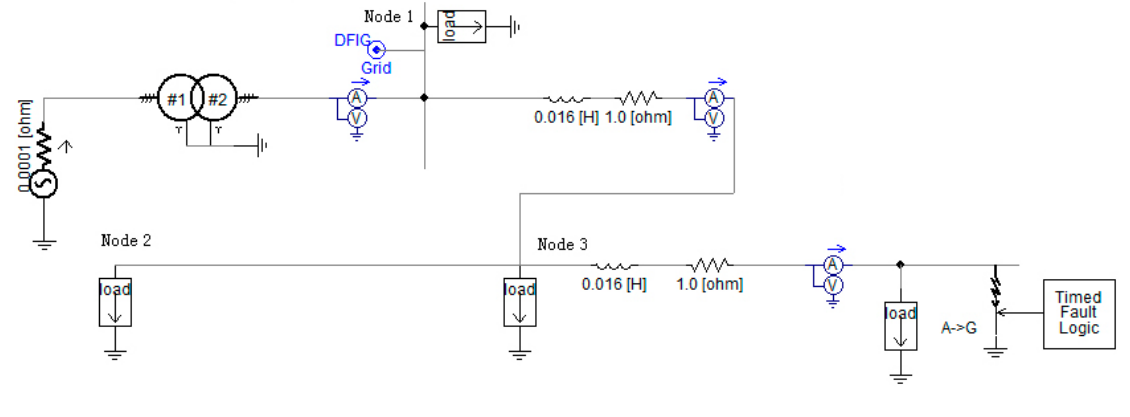
Figure 1. The distribution grid.